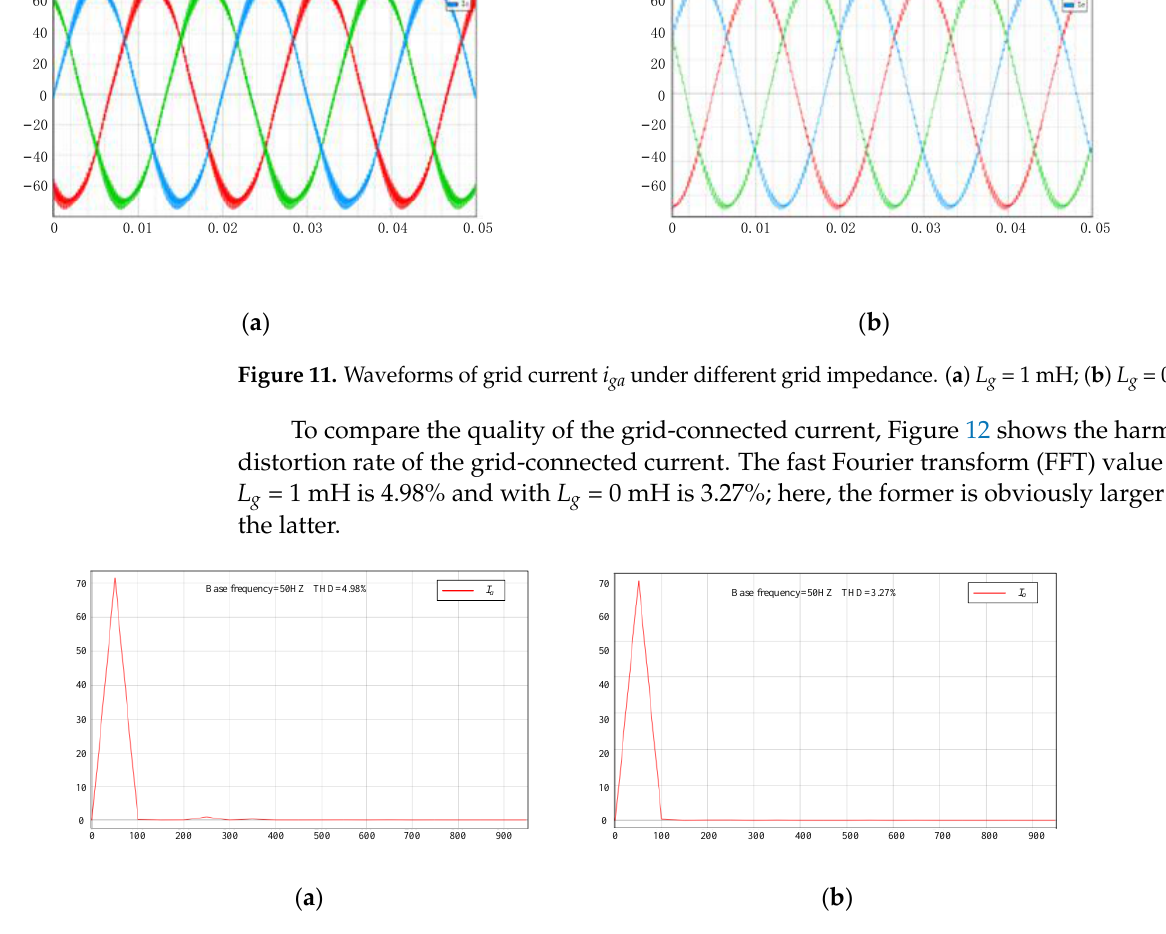
Figure 12. FFT analysis of grid current i ga under different grid impedance. ( a ) L g = 1 mH; ( b ) L g = 0 mH.